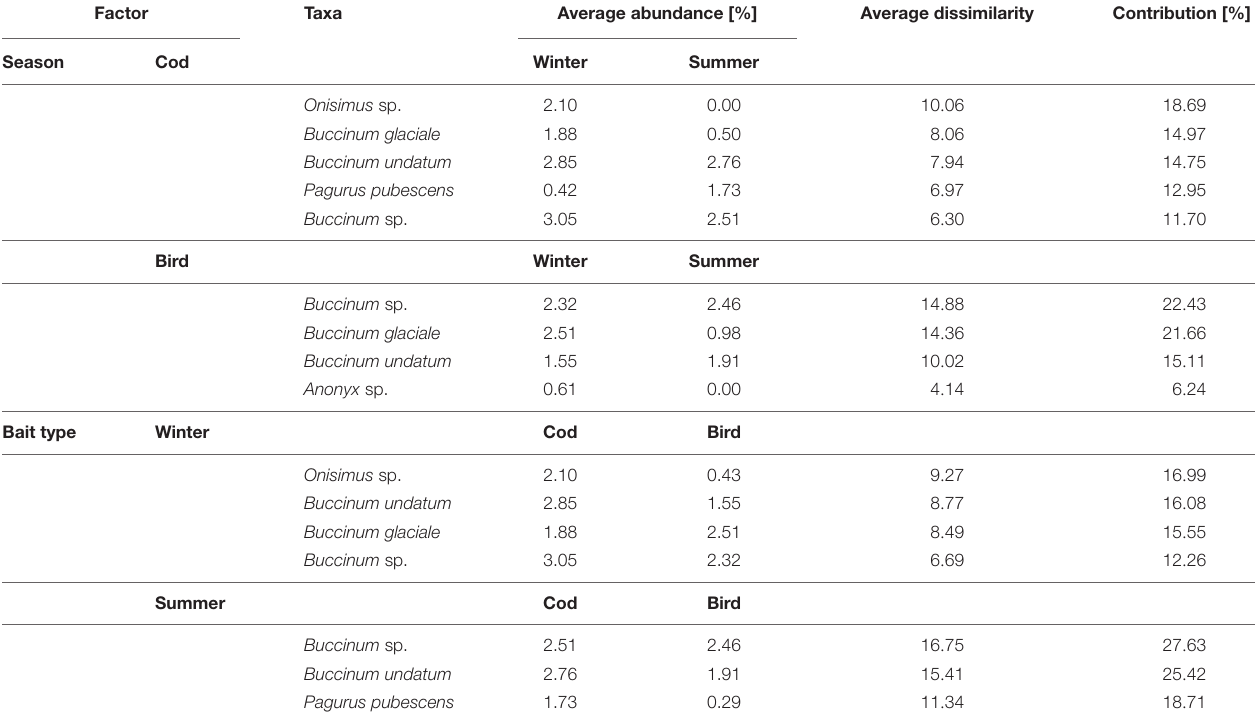
TABLE 5 | Results of SIMPER analyses identifying taxa with the highest contributions to observed differences between the Seasons and Bait types.